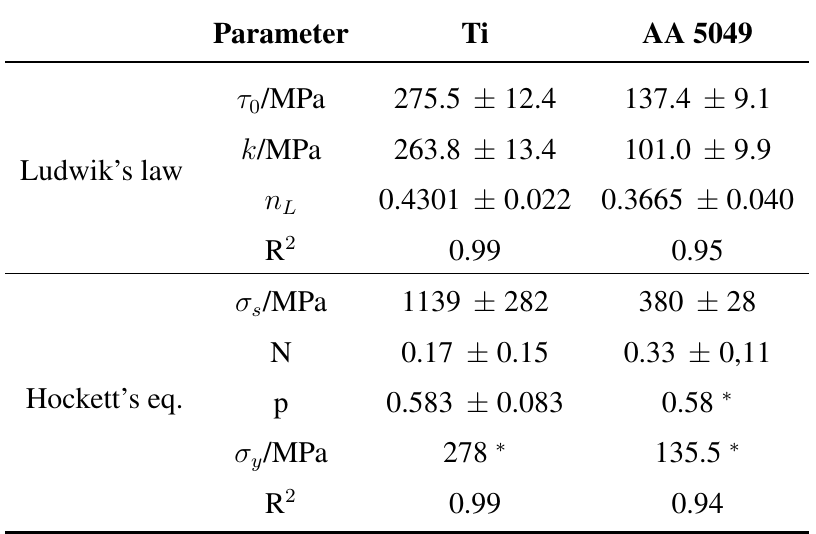
Table 1. Fitting parameters used for fitting flow curves according to Equations (1) and (2).